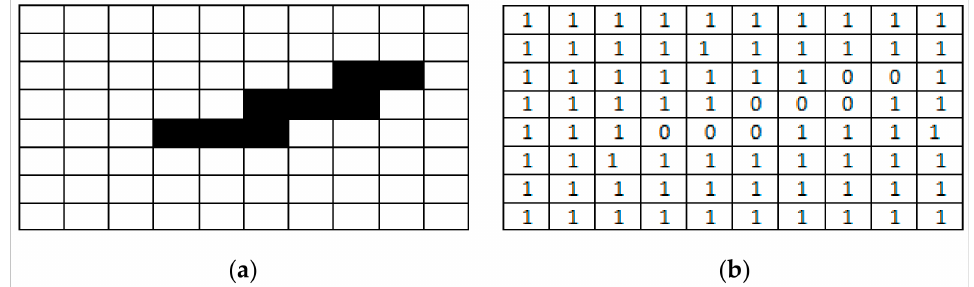
Figure 7. Pixelated image representation ( a ) and the corresponding binary format interpretation ( b ) of the colour black and white in an